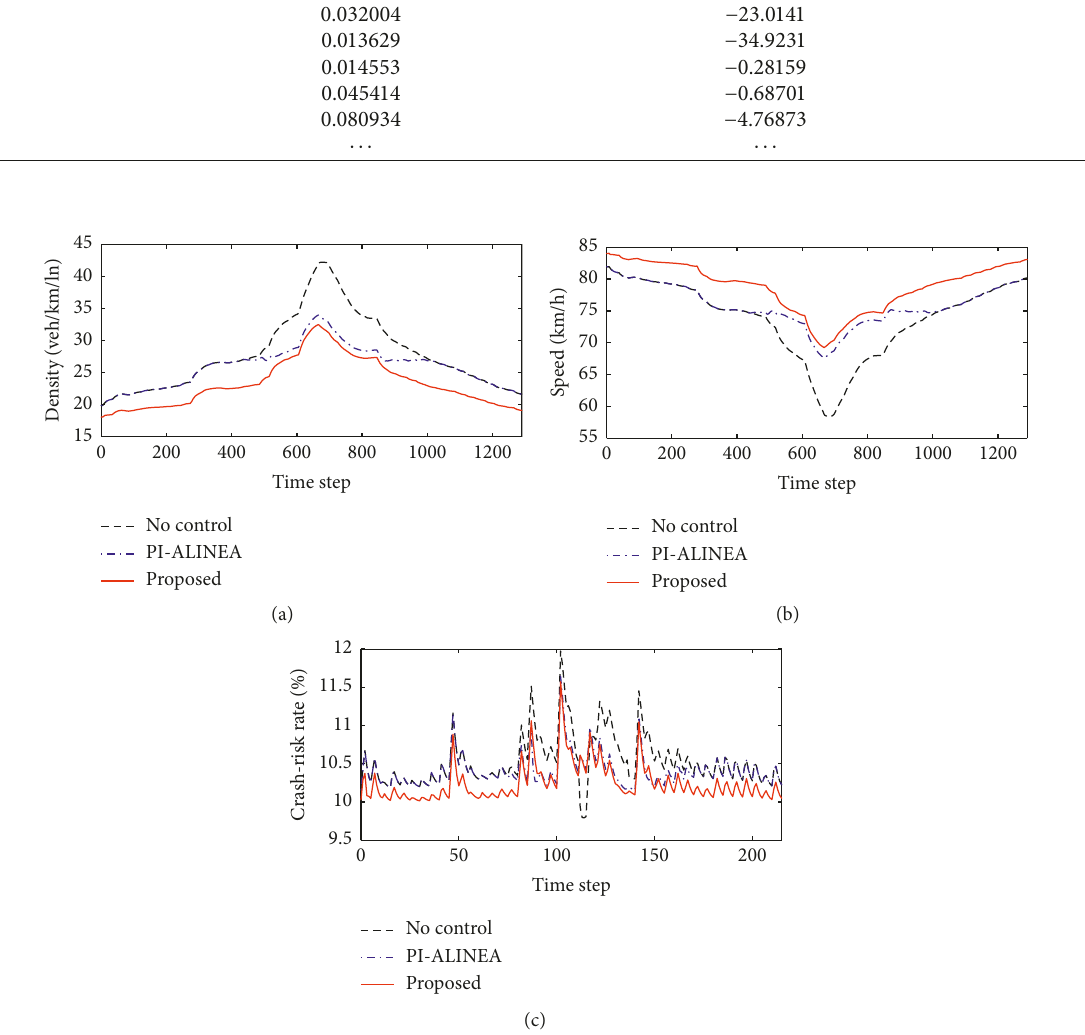
Figure 9: (a) Mainstream density, (b) mainstream speed, and (c) real-time crash-risk probability of different local ramp metering